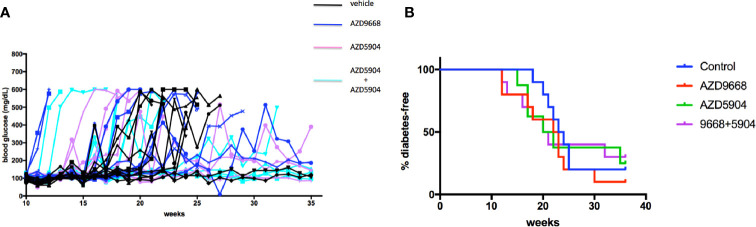
Diabetes incidence in NOD mice treated with AZD9668 alone or together with AZD5904. (A) Blood glucose concentrations in individual NOD female mice treated with AZD9668, AZD5904 alone, or in combination. Mice were allowed access to chow-formulated agents ad libitum beginning at 5 weeks of age. Blood glucose was measured once weekly until the time of diabetes confirmation. An n = 8–10 mice per treatment arm was monitored for the duration of this experiment. (B) Survival analysis. Log-rank test of the number of mice that became diabetic among all the treatment arms demonstrated that the study agents alone or in combination were ineffective in delaying or preventing the progression to diabetes compared to mice in the control treatment arm (p = non-significant).